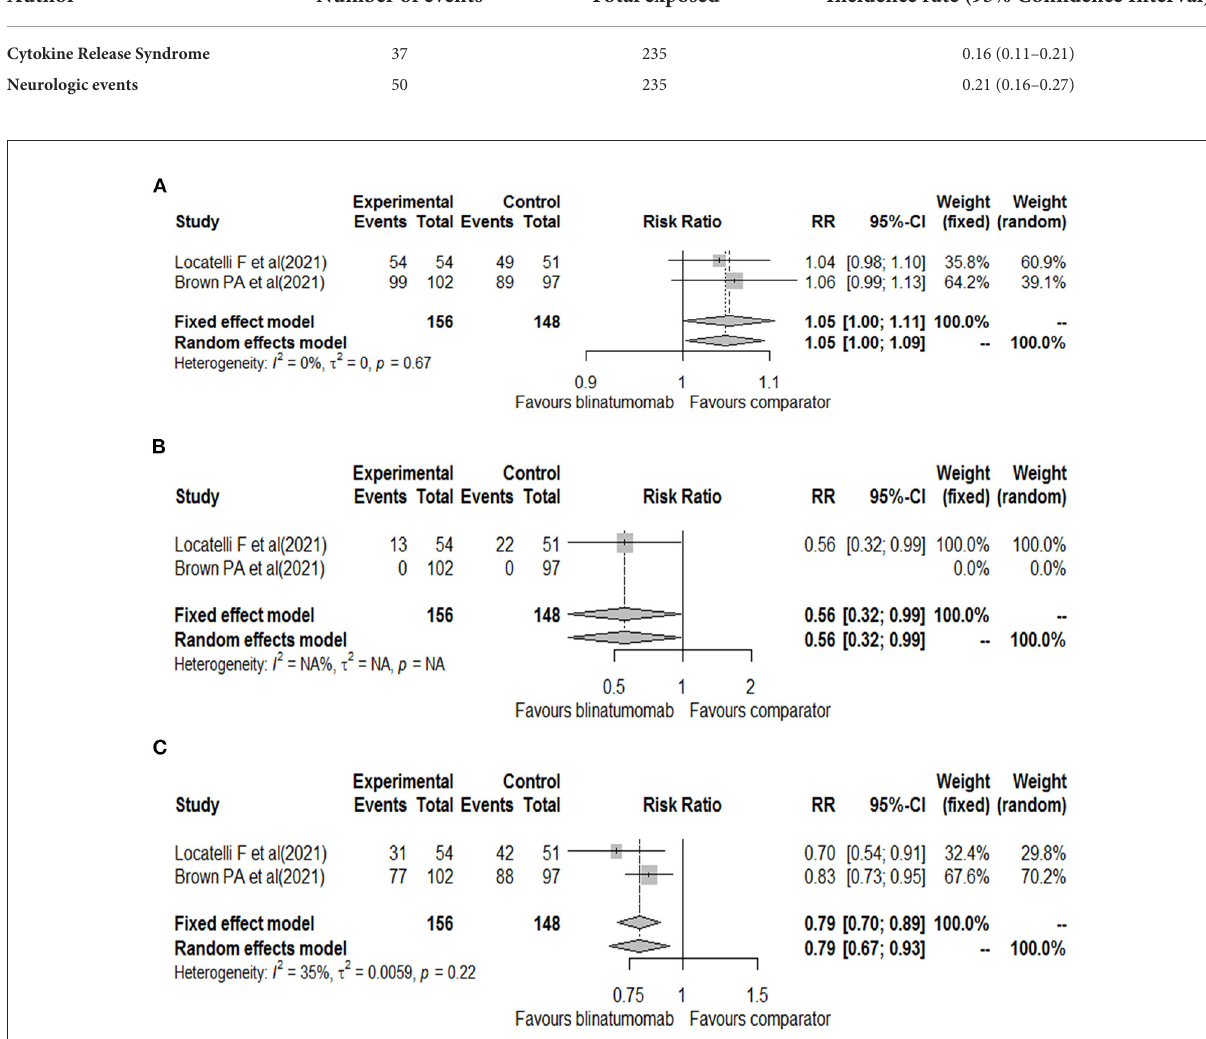
FIGURE2 Forest plot of total adverse events (A) , serious adverse events (B) , and grade ≥ 3 adverse events (C) with blinatumomab vs.